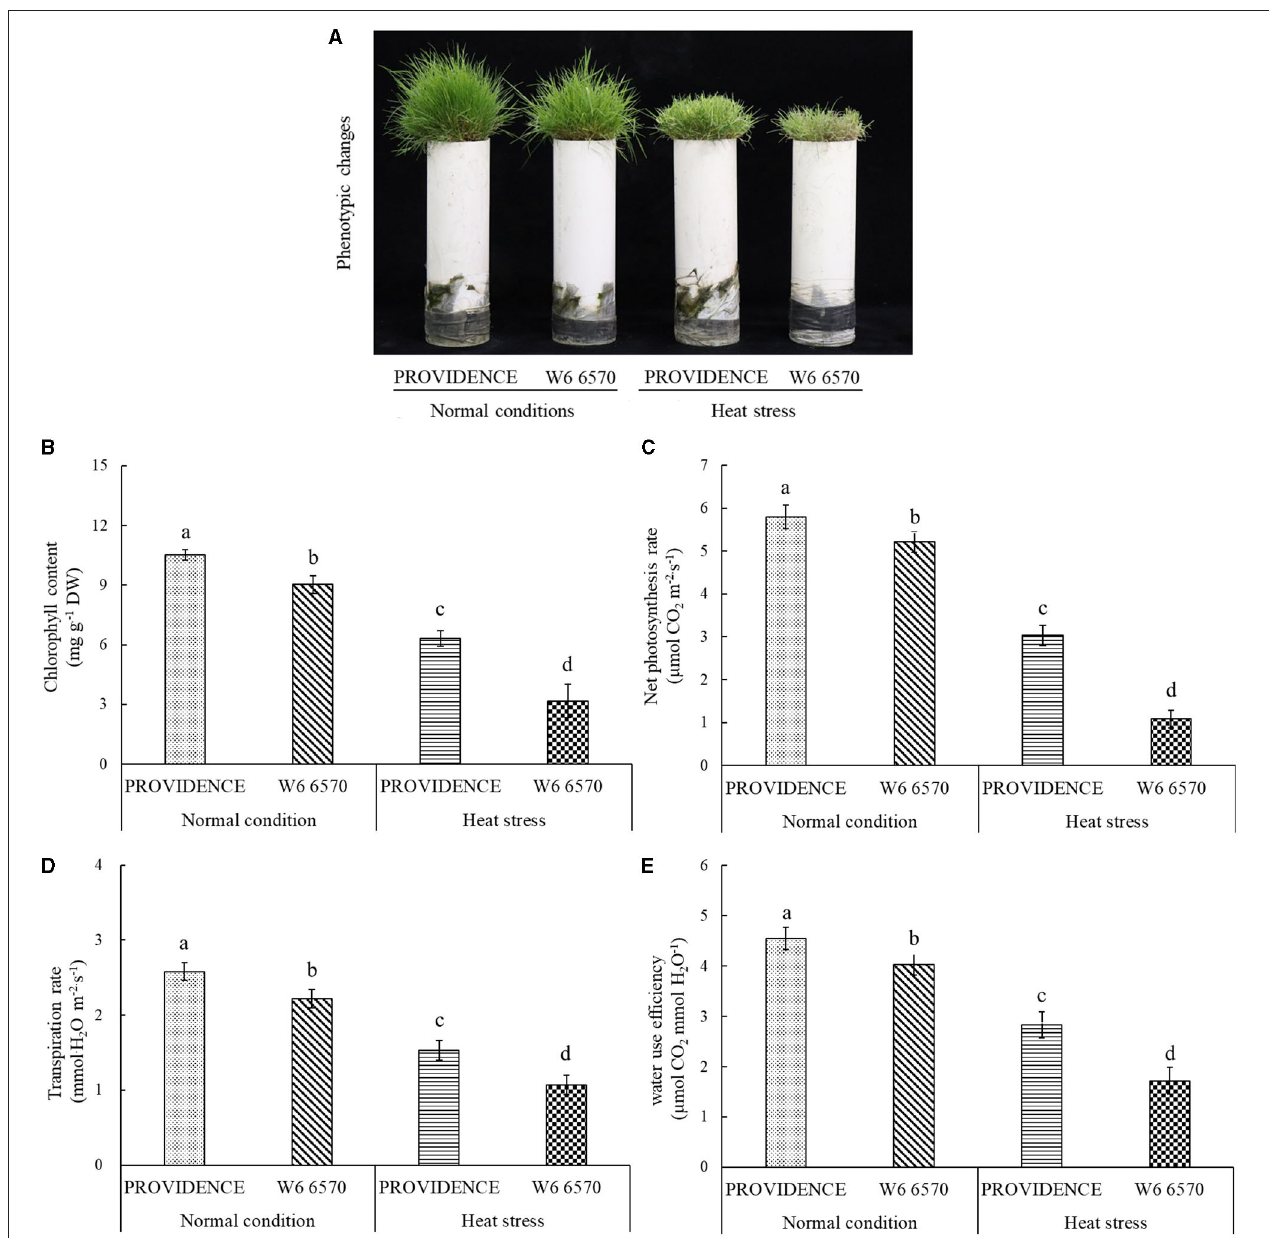
FIGURE 3 | Changes in (A) phenotype, (B) chlorophyll content, (C) net photosynthetic rate, (D) transpiration rate, and (E) water use efficiency in leaves of two creeping bentgrass materials (PROVIDENCE and W6 6570) in response to 15 days of heat stress (38/33 ◦ C, day/night) in controlled growth chambers. Vertical bars indicate ± standard error (SE) of mean ( n = 4), and different letters above column indicate significant differences ( P ≤